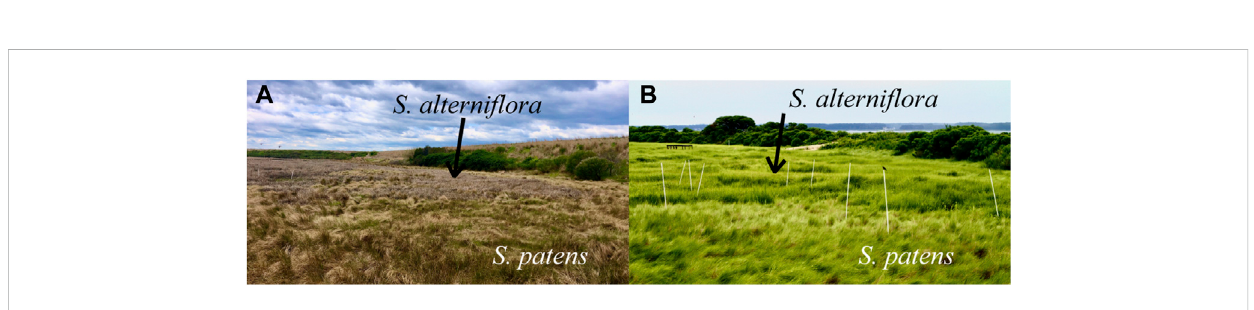
FIGURE 7 Field photos capturing spectral and structural differences between Spartina alterni fl ora and Spartina patens during the (A) fall and (B) summer